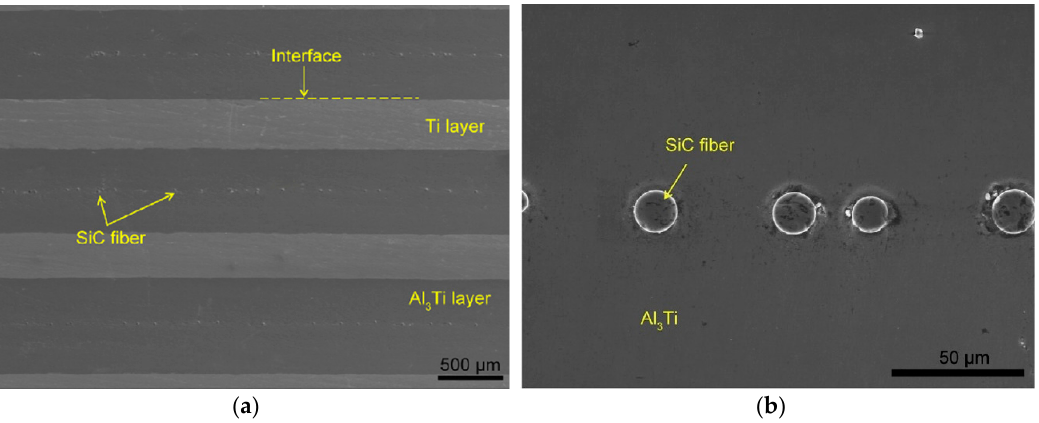
Figure 1. Microstructure images of Ti-(SiC f /Al 3 Ti) composite: ( a ) lower magnification and ( b ) higher magnification showing the laminated structure comprised of alternating SiC f /Al 3 Ti composite layers and Ti layers.